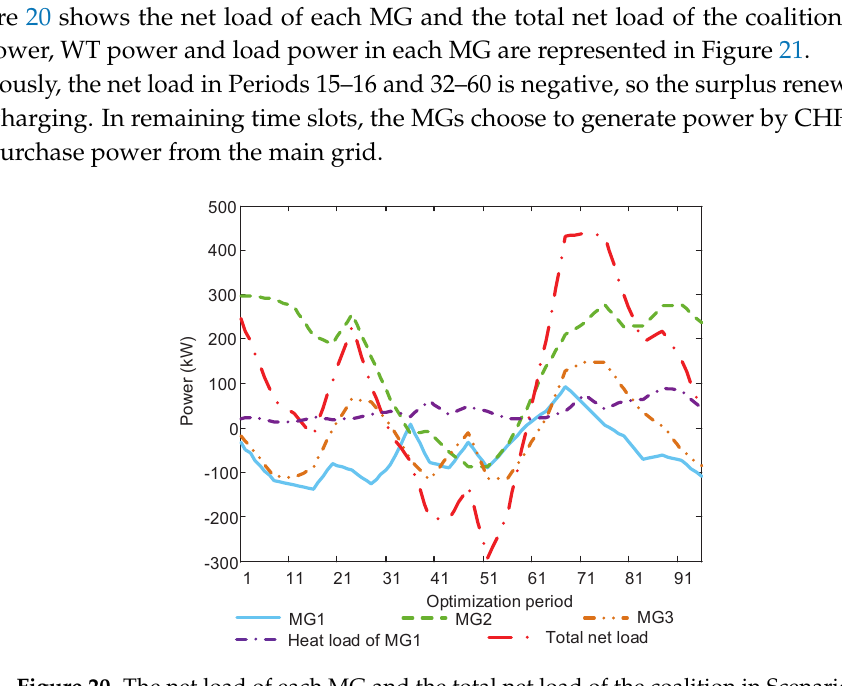
Figure 20. The net load of each MG and the total net load of the coalition in Scenario 2.